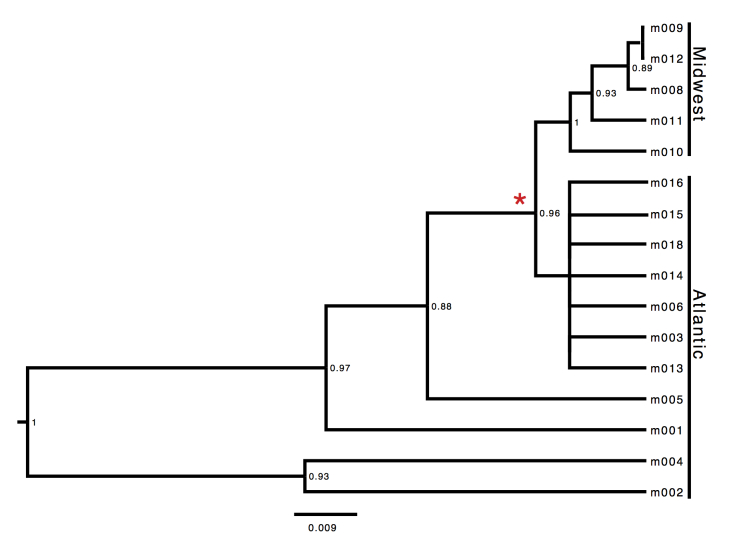
Nodes possessing <0.85 posterior probabilities were collapsed. Red star represents the Mohawk-Hudson Divide, with the prior of the node age set to a normal distribution with a mean age of 10,739.5 cal BP. The Midwest specimen m010 fell outside of the Midwest clade prior to constraining the group to monophyly.